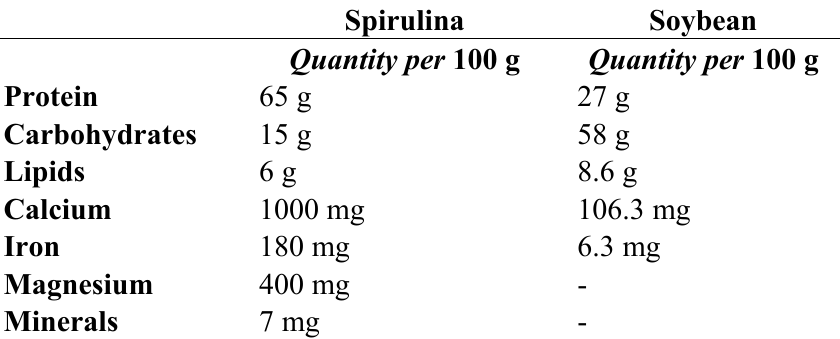
Table 1. Composition of spirulina and soya beans used in the